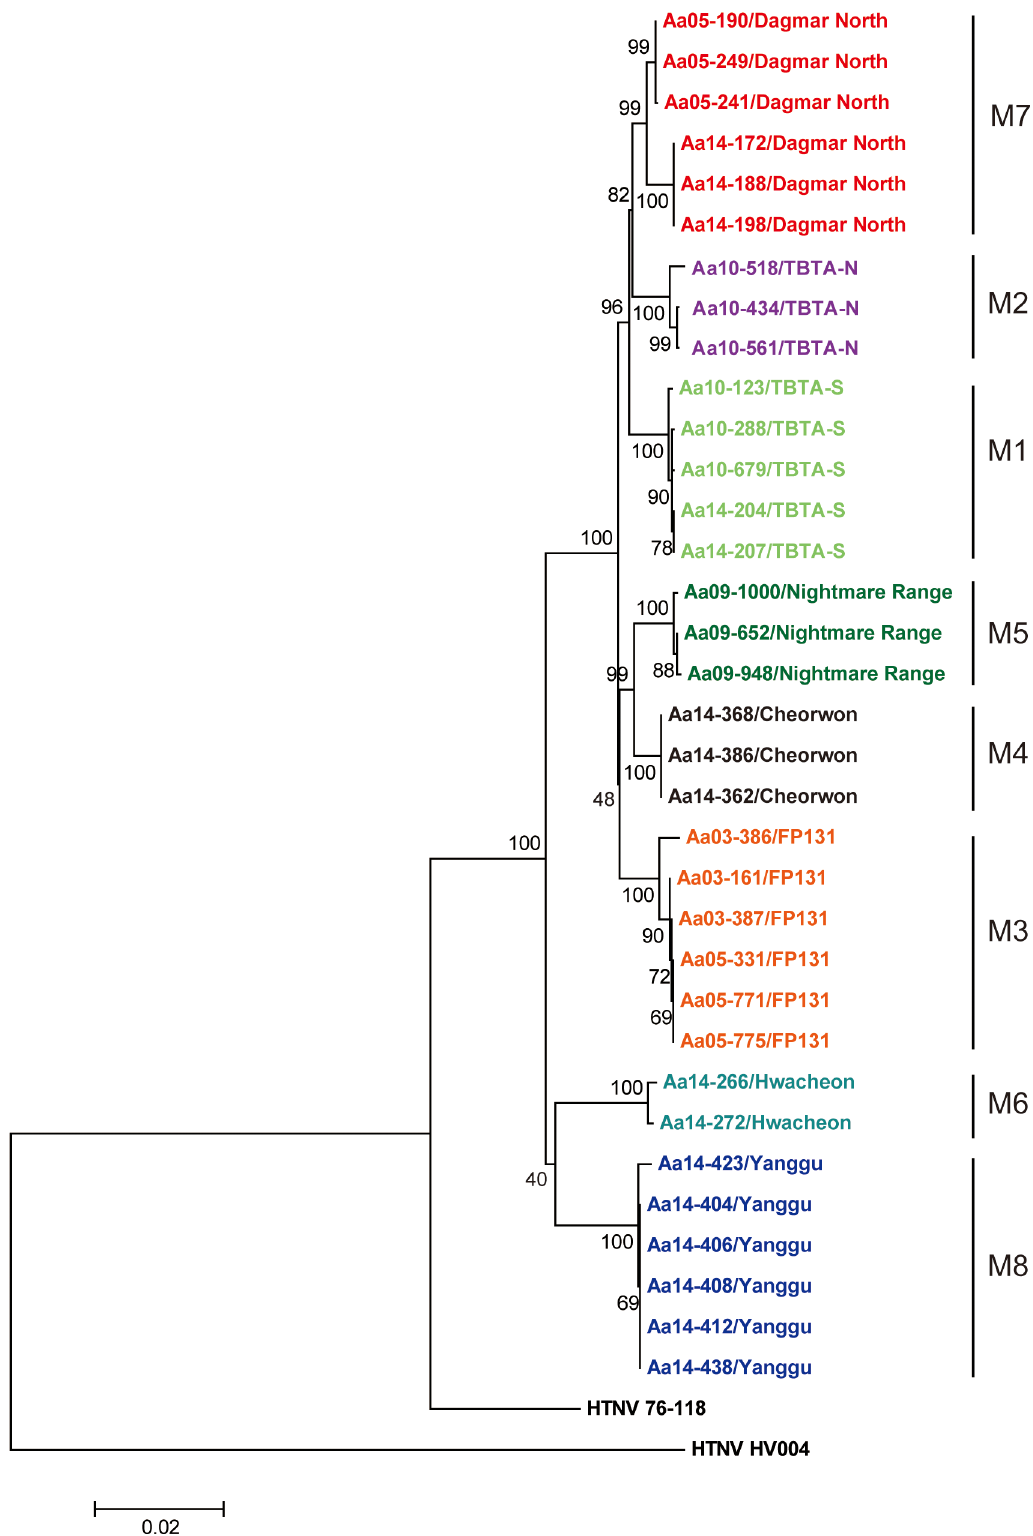
Fig 4. Phylogenetic analysis of whole HTNV M segment genomic sequences in Gangwon and Gyeonggi provinces. The full-length sequences of the HTNV M segment were obtained from lung tissues of A . agrarius